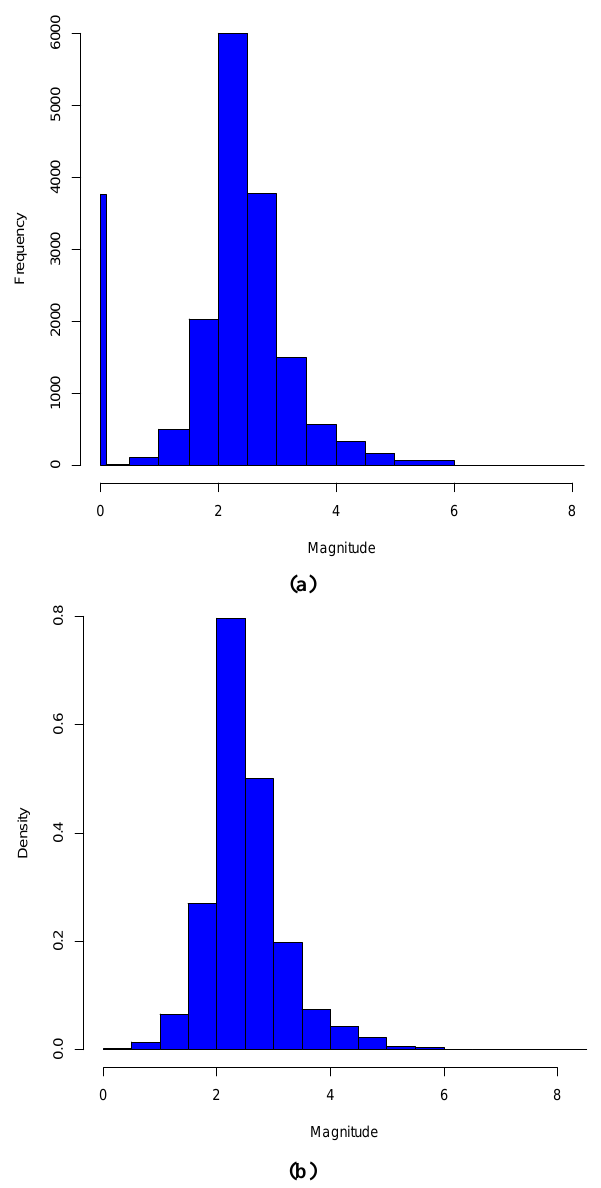
Figure 7a) Histogram of absolute frequencies of S; b) Histogram of S togram of S w 0